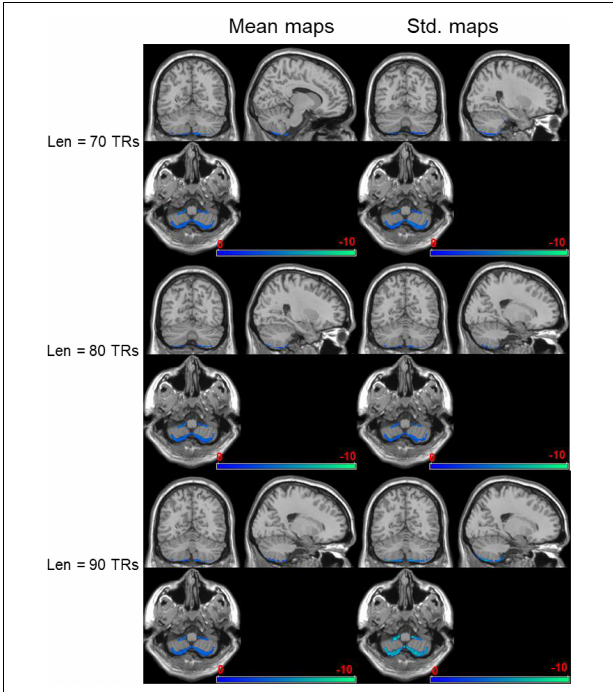
FIGURE 4 | Negatively activated brain regions regarding dynamical brain entropy maps (seafarers’ entropy value < non-seafarers’ entropy value; AlphaSim correction, p <